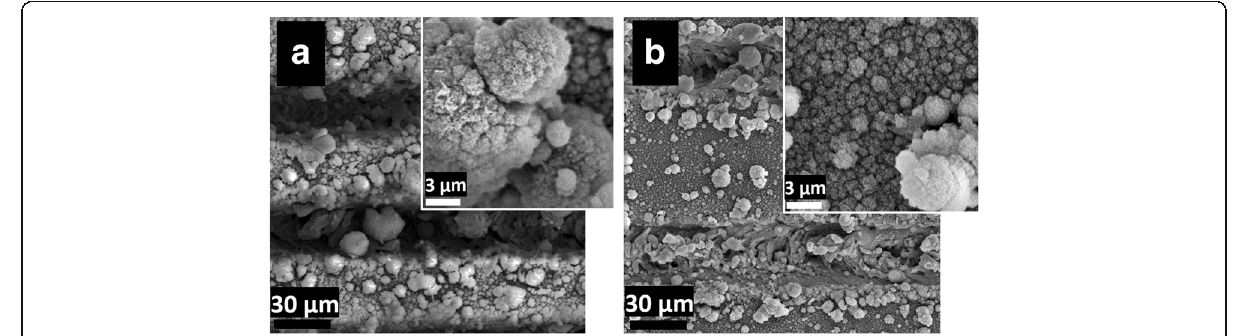
Fig. 2 SEM images of laser processed silicon at five overlaps (OL) with line spacing of a 0.1 mm, b 0.15